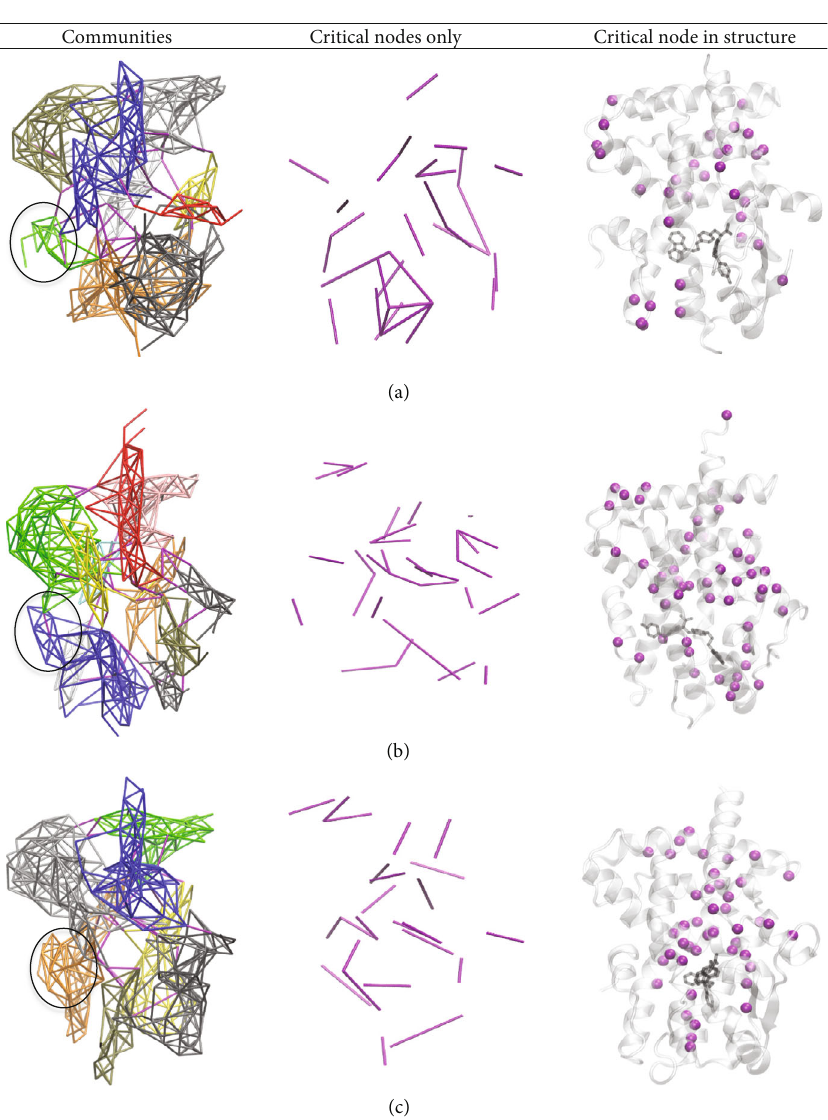
Figure 12: Model of structural communities separated by color with critical nodes shown in purple for PPAR α (a), PPAR β (b), and PPAR γ (c). Helix 12 is